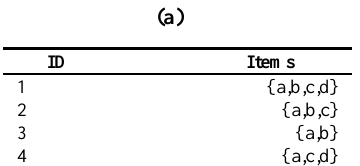
Table 2. (a) Transaction data, (b) Frequent itemsets, (c) Association rules.